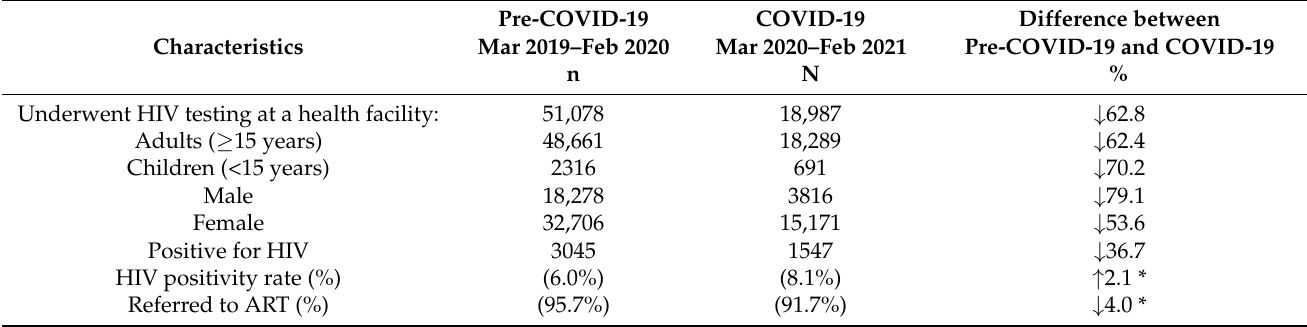
* absolute change (increase or decrease);  = increase;  = decrease; ART = antiretroviral therapy.